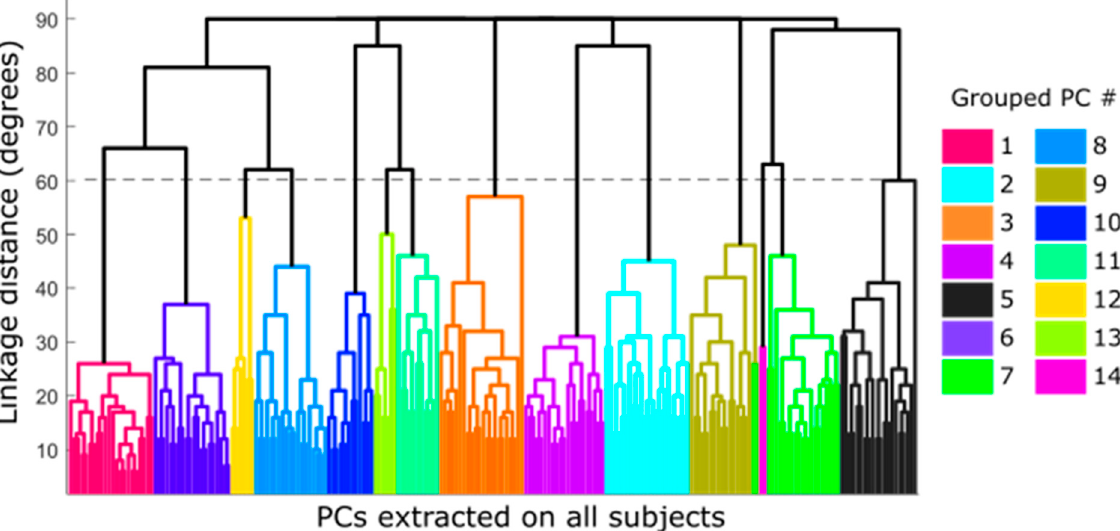
Figure 4. Dendrogram for cluster composition of the extracted principal components (PCs). The horizontal axis represents all the PCs with 220 numbers of clustered nodes; vertical axis represents the pairwise distance between the observed PCs.